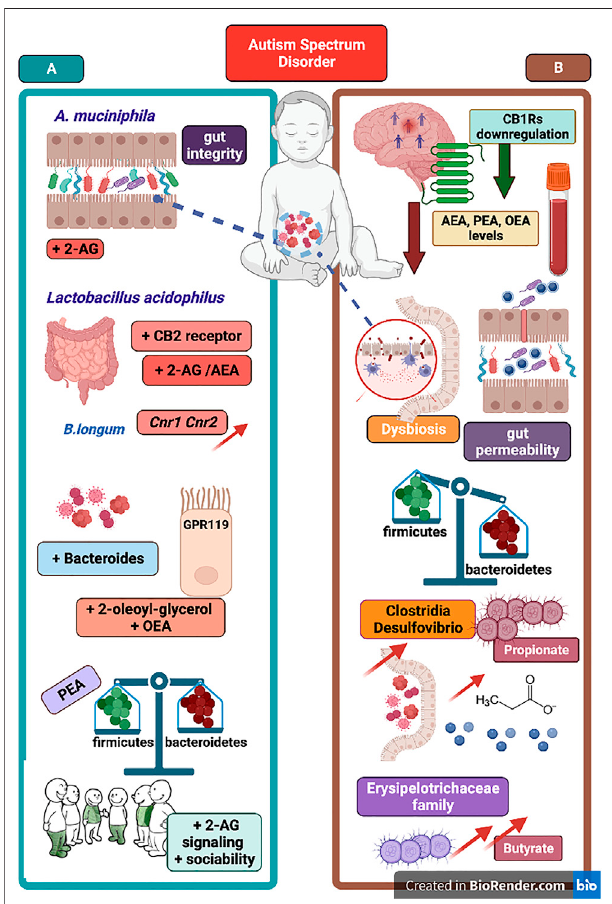
FIGURE 3 | The fi gure portraits selected evidence in support of eCB signaling-gut microbiota relationship and representative mechanisms underlyingthelinkbetweenASDpathophysiologyandtheeCBmachinery.On the left panel (A) , A. muciniphila supplementation can improve gut permeability and recover gut integrity as well as increase 2-AG signaling. Supplementation of Lactobacillus acidophilus increase both 2-AG and AEA signaling and CB 2 receptor mRNA expression in mice colon and in human epithelial cells. B. Longum supplementation is associated with increase of Cnr1 and Cnr2 genes intestinal expression. Below, an overall growth in Bacteroides population can produce an increase of eCB-like lipids (e.g., OEA and2-OG)actingasGPR119ligands.Recoveryofgutmicrobialbalance(e.g., Firmicutes to Bacteroides ratio) can be associated with PEA supplementation and anincreaseof2-AGsignalingcauseanimprovementofsociability.Onthe right panel (B) , downregulation of CB 1 receptors found in brains of subjects withautism,anddecreaseofserumAEA,PEAandOEAlevelsinASDpatients. Below, some evidence of dysregulation of gut microbial community and reduced bacteria diversity.Gutdysbiosisin ASDis characterized by disrupted gut barrier integrity and increased gut permeability as well as by a general Firmicutes to Bacteroides imbalance. Next, the increase of Clostridia and Desulfovibrio bacteria as well as of Erysipelotrichaceae family are responsible of excessive propionate- and butyrate-producing bacteria, respectively. Boosting eCB tone and 2-AG and AEA signaling via prebiotics supplementation emerges as potential therapeutic via changes of gut microbial communities found defective in ASD